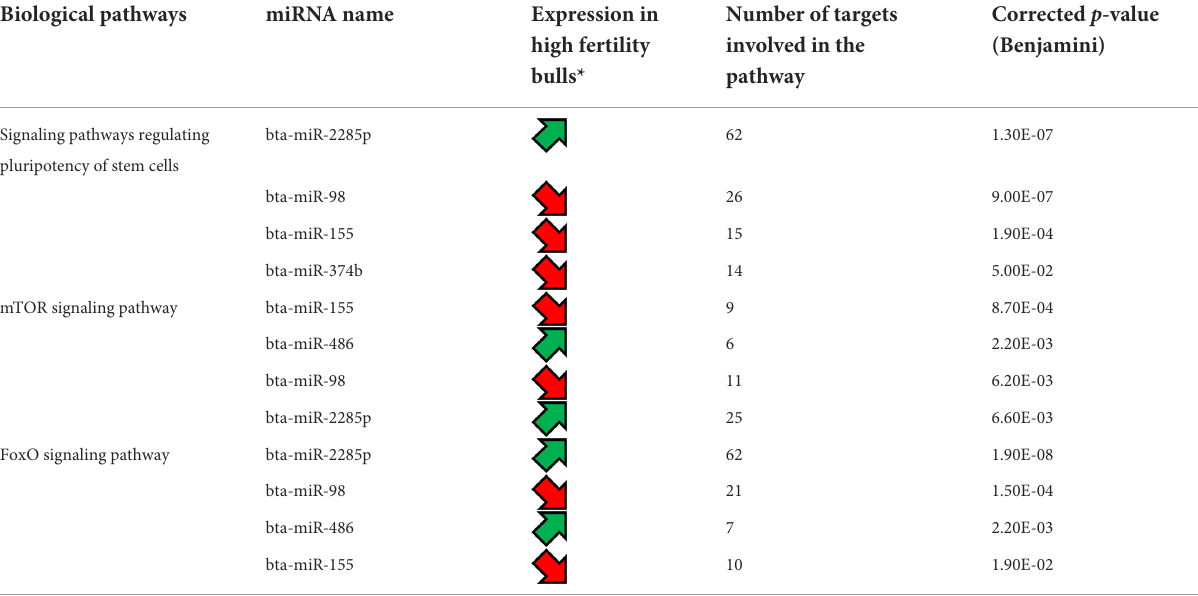
TABLE 4 Biological pathways targeted by the differentially expressed miRNAs between high fertility and low fertility bulls. Biological